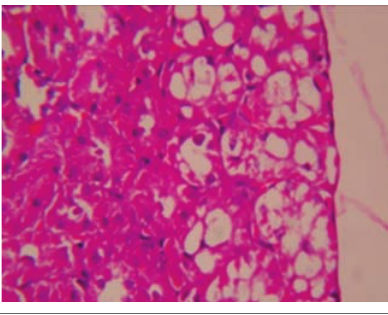
Figure 4. Liver of Kushta Sammulfar -III showing moderate congestion in central vein hepatic vein, portal triad and lym- phatic